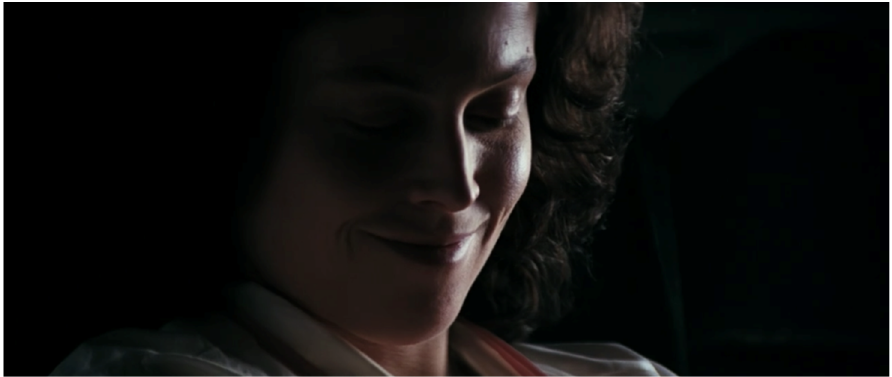
Figure 5. Ellen Ripley petting Jones at the end of Alien : “Come on,